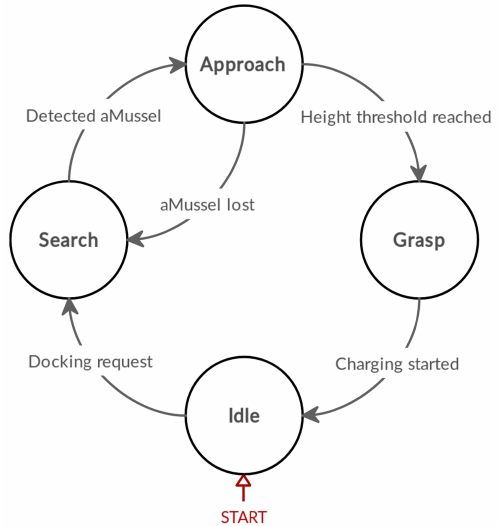
Figure 9. State machine representation of the aPad high-level controller implementing the phases of the docking